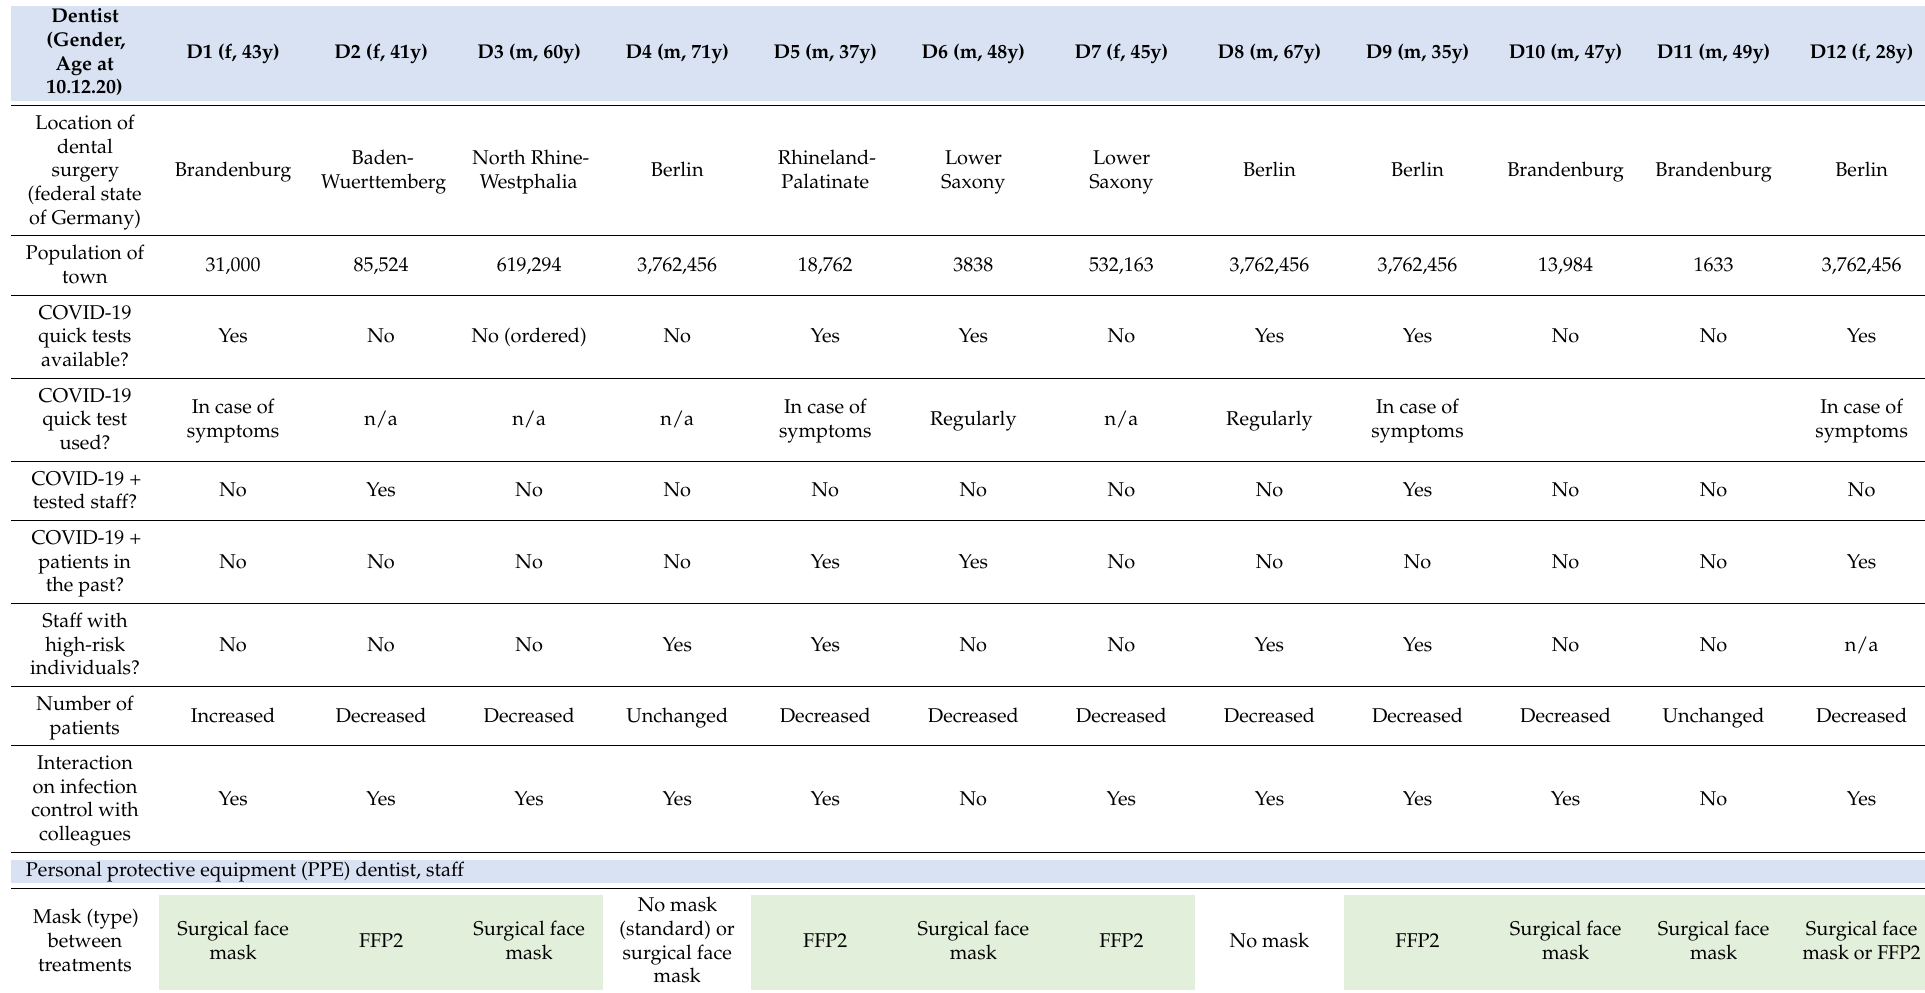
Table 1. Dentists’ (D1 to D12) and practices’ characteristics (upper panel) and the implementation of different infection control measures for COVID-19 (lower panels). Dentist (Gender, Age at